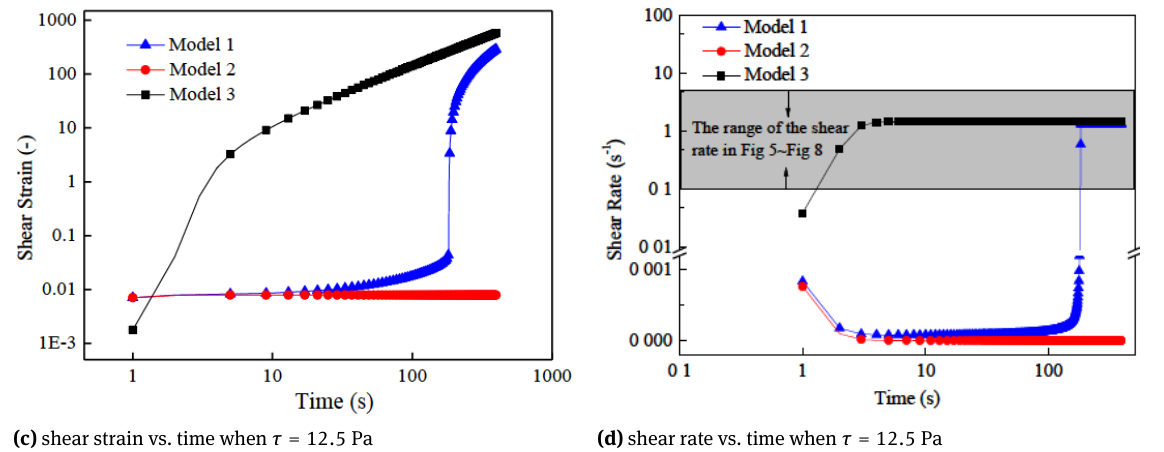
Figure 17: Shear strain and shear rate change over time under different shear stress conditions